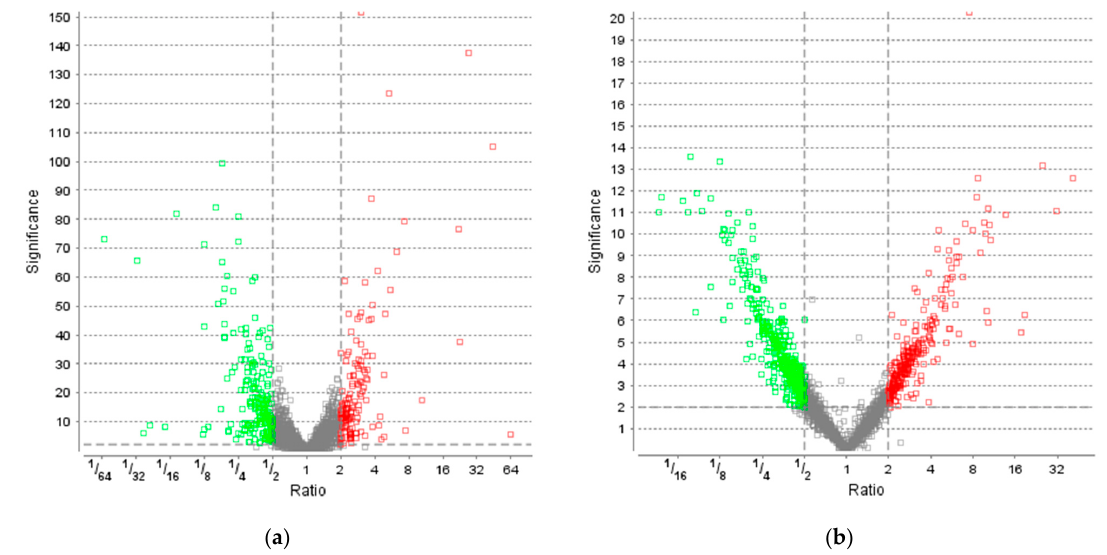
Figure 4. Volcano plots of proteins extracted from cultures grown under LED light compared to the control. Analysis was performed based on label-free quantification (LFQ). The significance is plotted against the fold change ratio. The non-axial vertical lines denote fold change thresholds of 2 (upregulated ≥ 2 in red and downregulated ≤ 0.5 in green), the non-axial horizontal lines denote a significance threshold of 2. Figure compiled by PEAKS Studio Xpro. ( a ) Volcano plot after 40 h. ( b ) Volcano plot after 122 h.